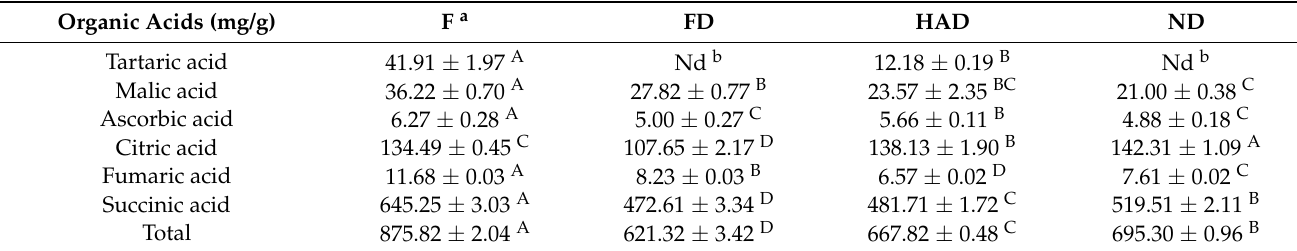
Table 2. Organic acid contents of fresh and different dried L. edodes